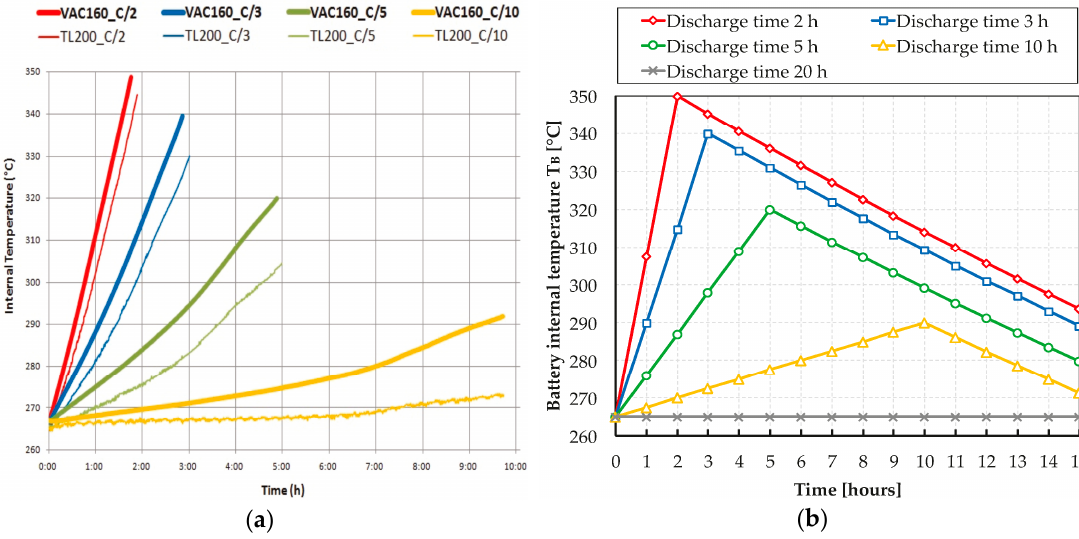
Figure 2. Thermal characterization of NaNiCl 2 batteries for residential applications. ( a ) Battery technical specifications, resulting from laboratory measurements of the time trends of the internal temperature T B with different discharging rates (2 h, 3 h, 5 h, and 10 h) for a couple of commercially-available battery models (VAC160, bold lines, and TL200); ( b ) Equivalent model for the representation of the thermal behavior of the studied battery model VAC160, for different discharging rates (in this picture, the horizontal axis is extended to 15 h to partially depict the cooling processes once the discharging phases end).